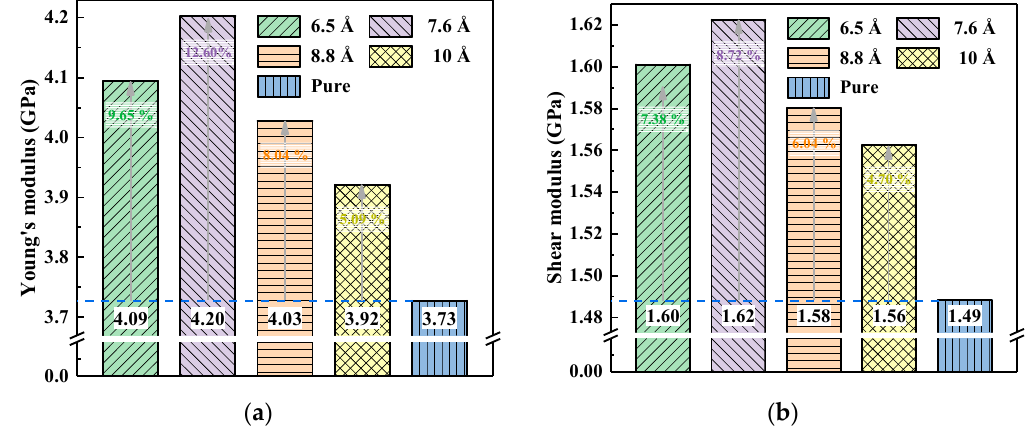
Figure 11. The static mechanical properties of the pure EP and composites with different particle sizes at a crosslinking density of 67%. ( a ) Young’s modulus; ( b ) shear modulus.